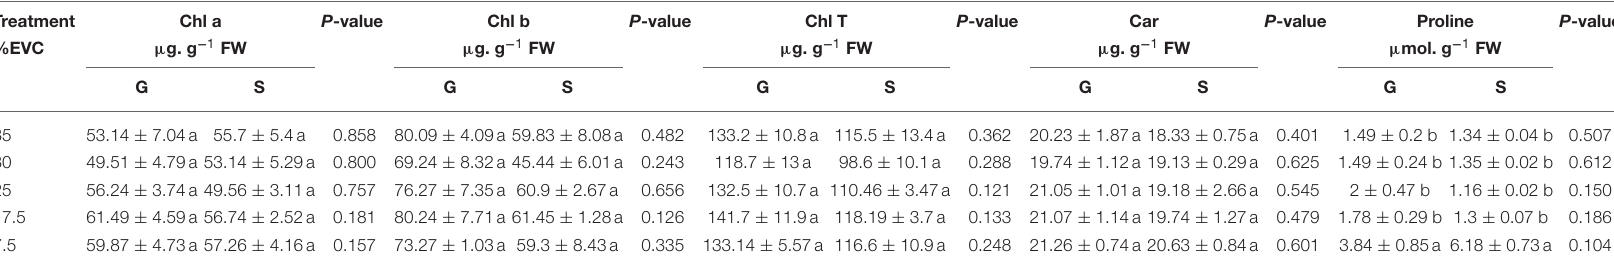
Different letters in the same column indicate significant difference at P < 0.05 (Fisher LSD test with 95% confidence). P-values for the effect of irrigation method at each irrigation level are presented in a separate column next to each